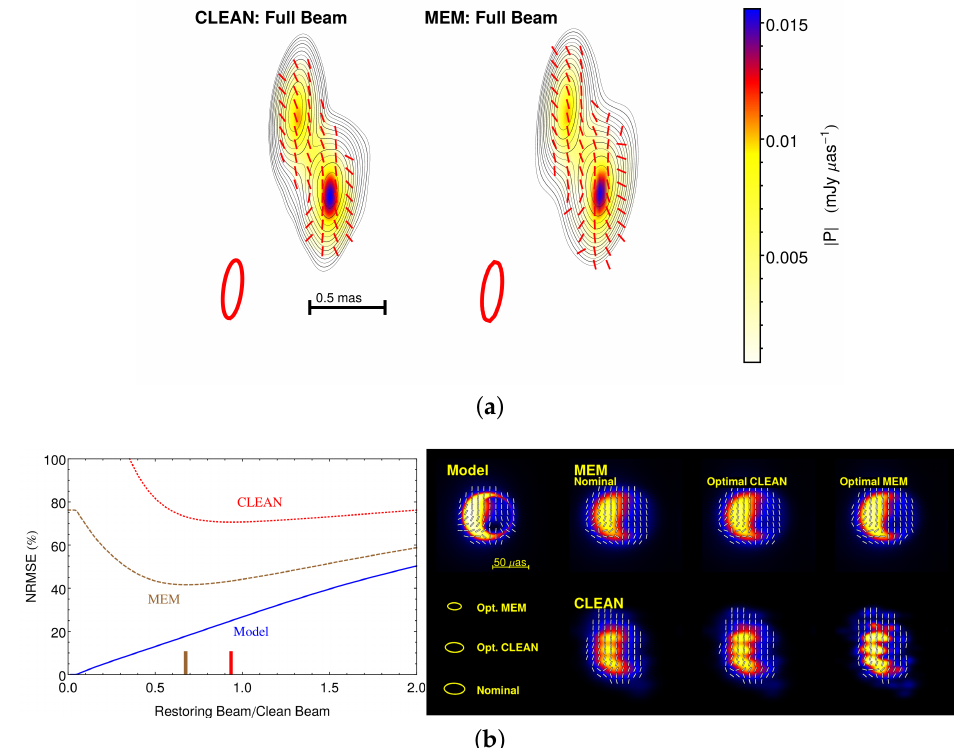
Figure 2. Validation and potential of polarimetric Maximum Entropy Method (MEM) imaging [45]. ( a ) Full-polarimetric images of 3C 279 from 7 mm Very Long Baseline Array (VLBA) data using CLEAN and MEM are nearly identical when the MEM image is convolved with the CLEAN beam; ( b ) Compared against a model image of Sgr A* at 1.3 mm, the normalized root-mean-square error of a polarimetric MEM reconstruction achieves its minimum at finer angular resolution than does CLEAN. MEM and CLEAN images reconstructed at the optimum beam sizes for each technique and the nominal beam size demonstrate that polarimetric MEM achieves superior resolution and image